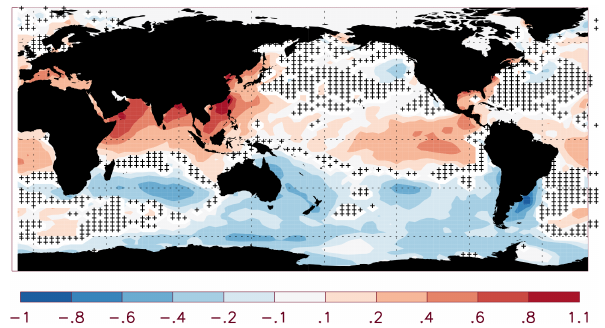
Figure 3. Trend in the annual-mean sea surface temperatures (SSTs), in HadISST for 1960–2010 (Kcentury − 1 ). Trends insignif- icant at 95% confidence are stippled.